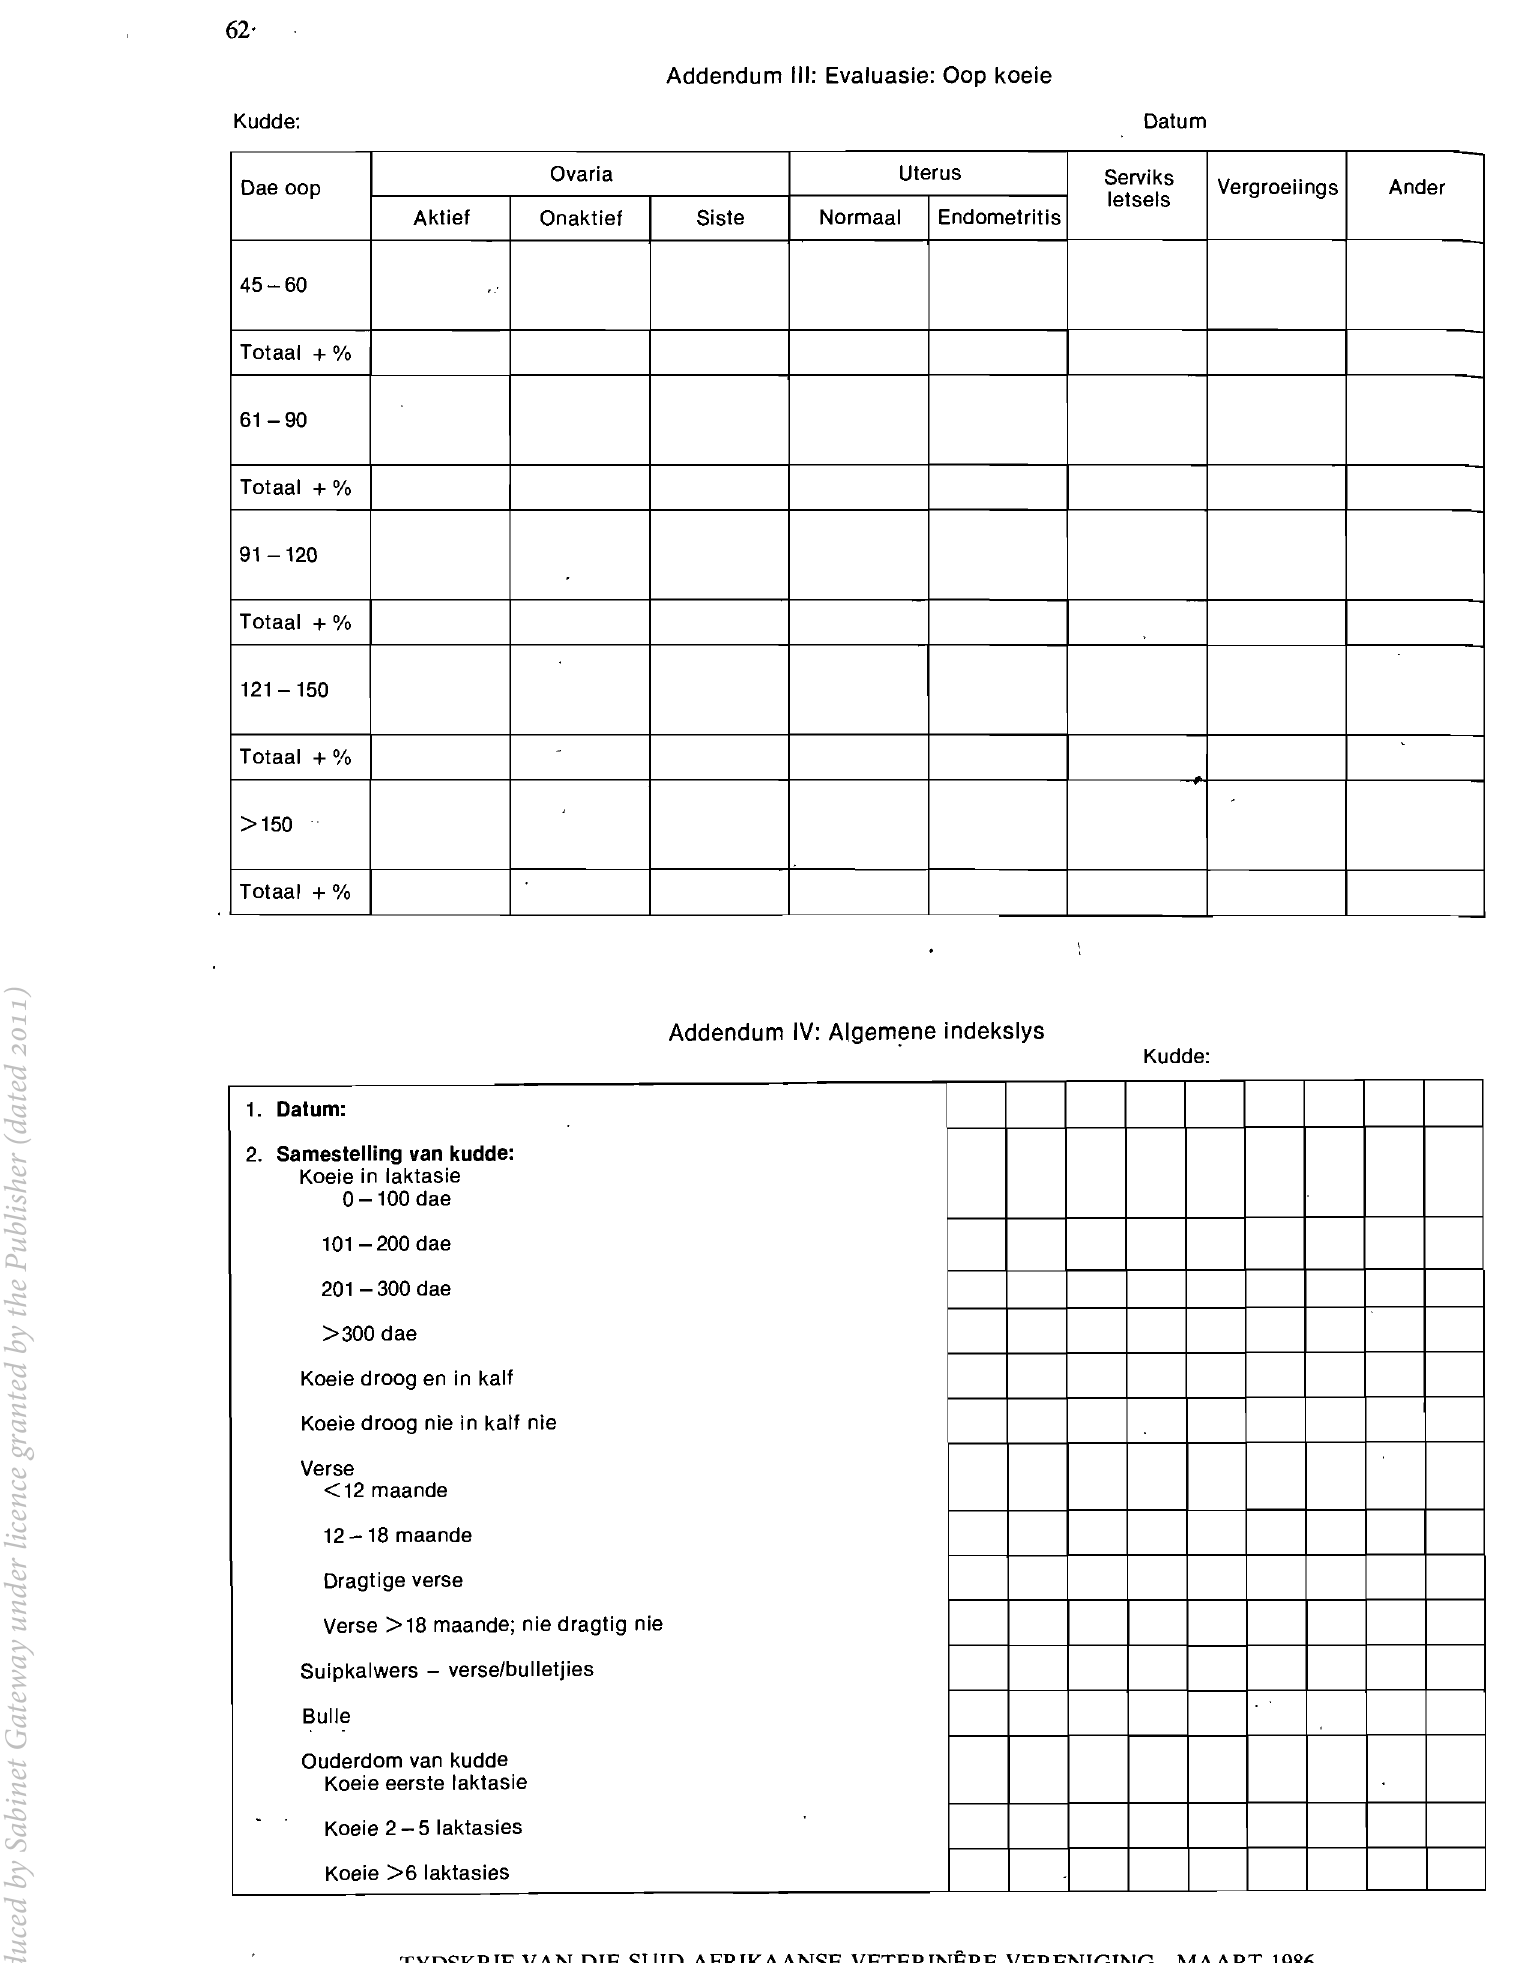
TYDSKRIF VAN DIE SUID-AFRIKAANSE VETERINERE VERENIGING.,..MAART